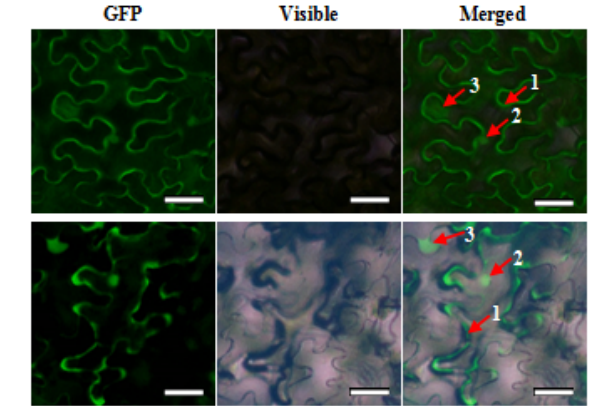
Figure 5. The subcellular localization analysis of ScChi in Nicotiana benthamiana leaves 48 h after infiltration. The epidermal cells were used for taking images of green fluorescence, visible light and merged light. Read Arrows 1, 2 and 3 indicated plasma membrane, nucleus and cytoplasm, respectively. Bar = 50 μ